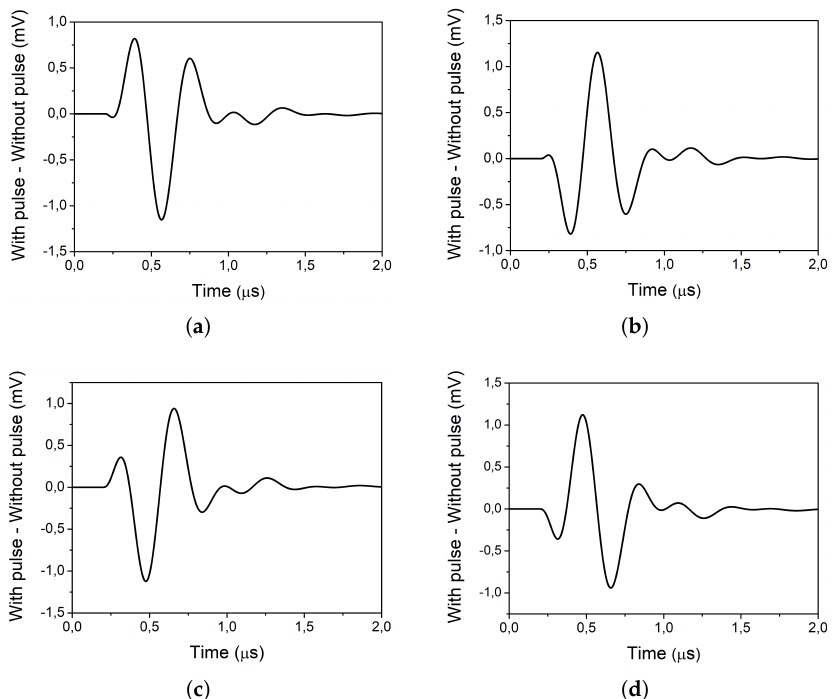
Figure 14. Effect of the pulse on the outputs of the complex filter ( a ) positive I branch ( b ) negative I branch ( c ) positive Q branch ( d ) negative Q